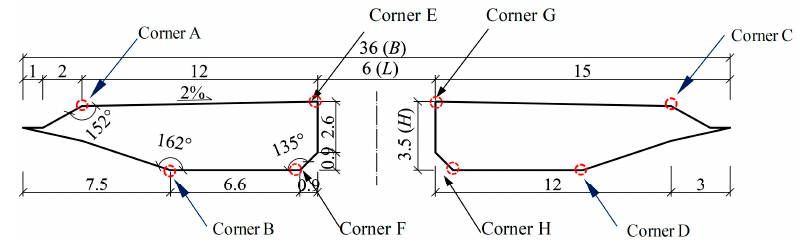
Figure 1. Geometric information of the twin-box girder (unit: